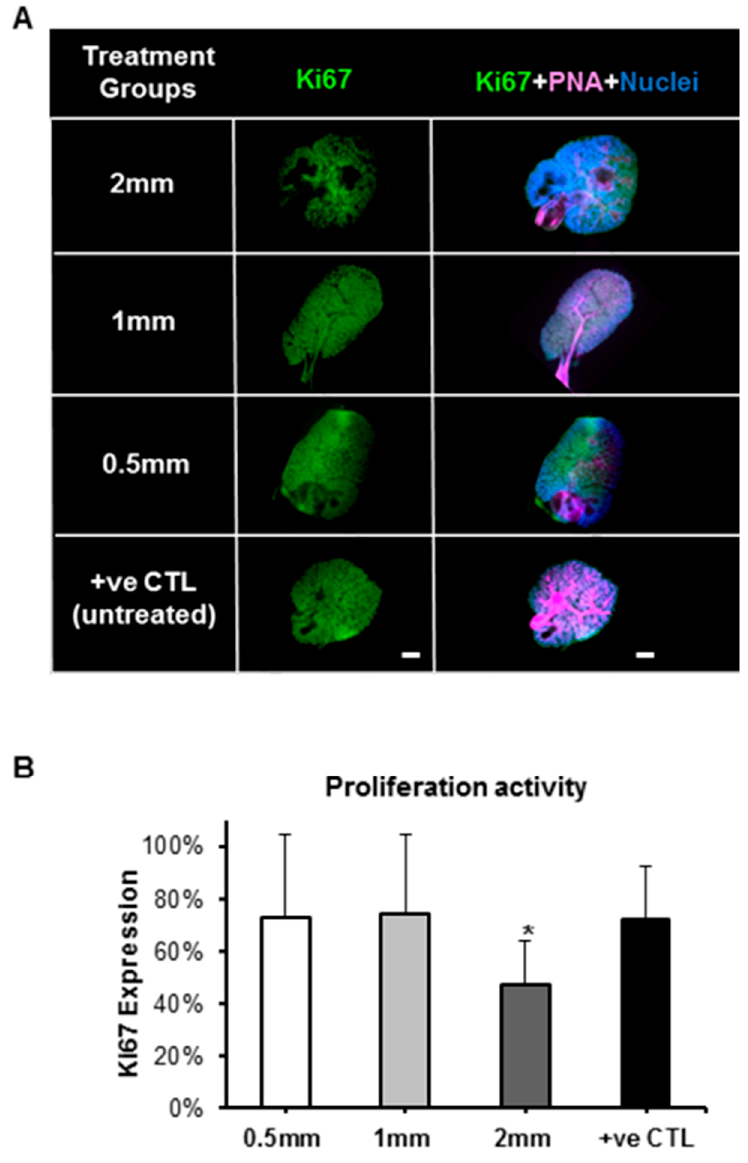
Figure 4. Expression of proliferation protein marker (Ki67) in SG after treatment with pilocarpine nanofiber mats after five culture days in the ex vivo SG model. ( A ) Fluorescence imaging after whole gland immunofluorescence staining showing expression of Ki67 in green (pro-mitotic marker), PNA in pink (peanut agglutinin staining the gland epithelial acini and ductal branched network) and nuclei in blue. ( B ) Expression of proliferation/pro-mitotic activity by quantification of Ki67 fluorescence after normalizing with nuclear counts. Error bars represent SD from n = 4. * p < 0.05 when compared to positive control. Positive control (+ve CTL) was not treated with nanofiber mats.